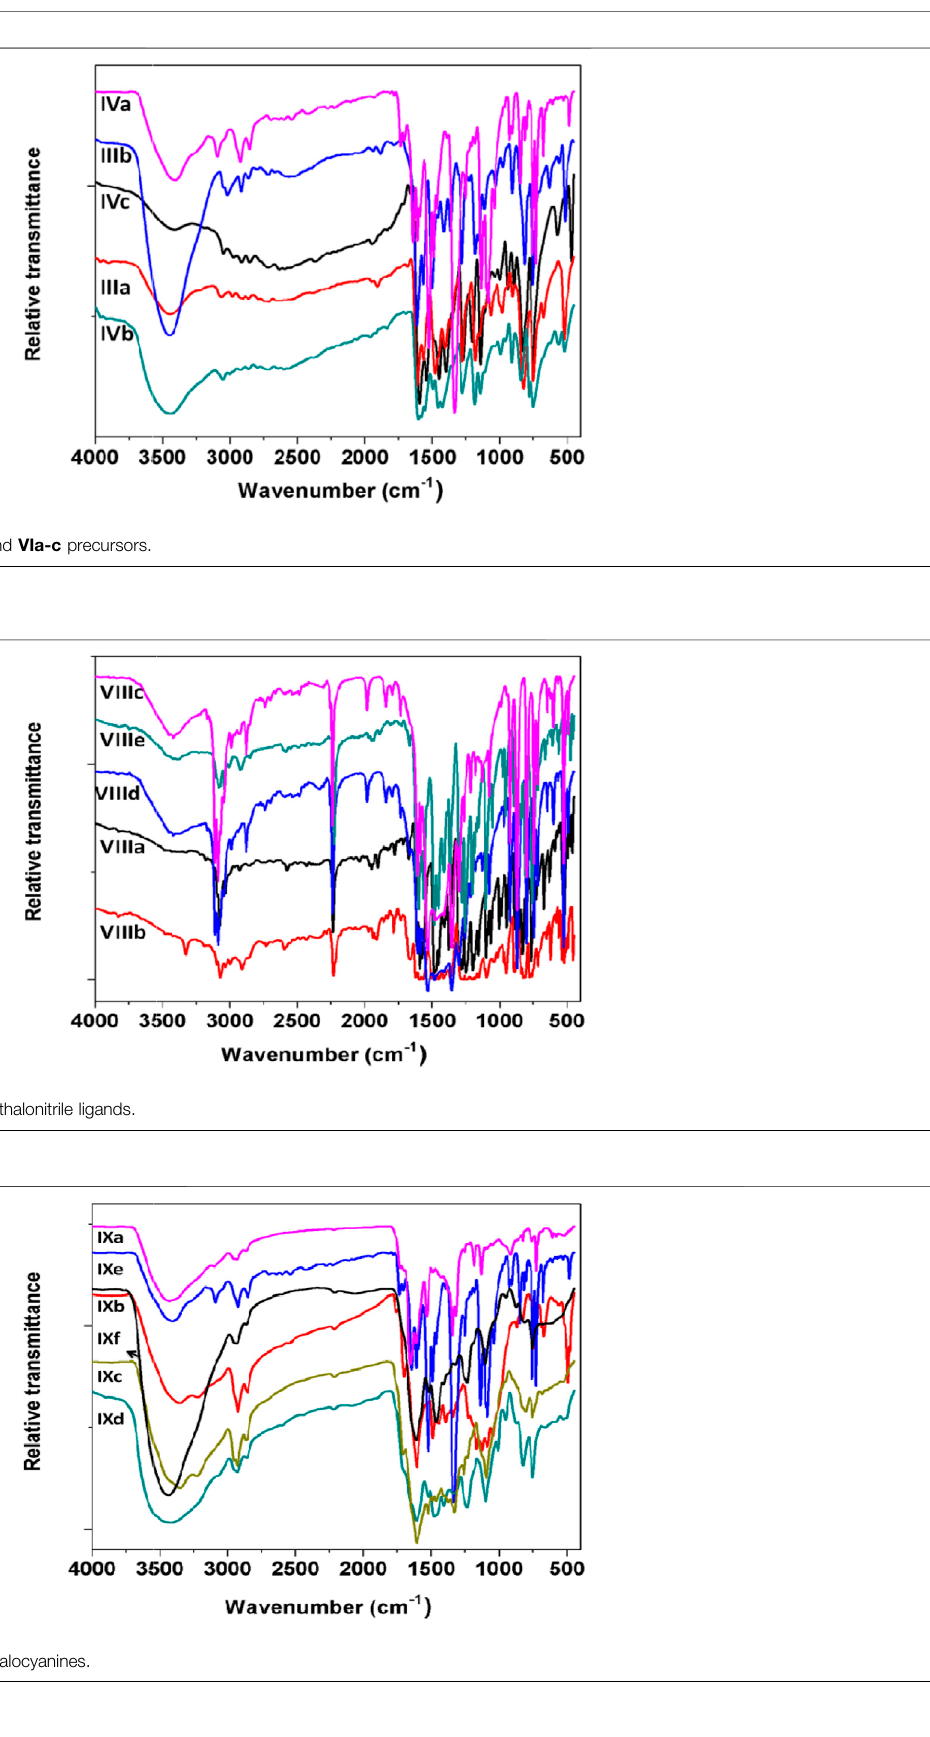
Frontiers in Chemistry |